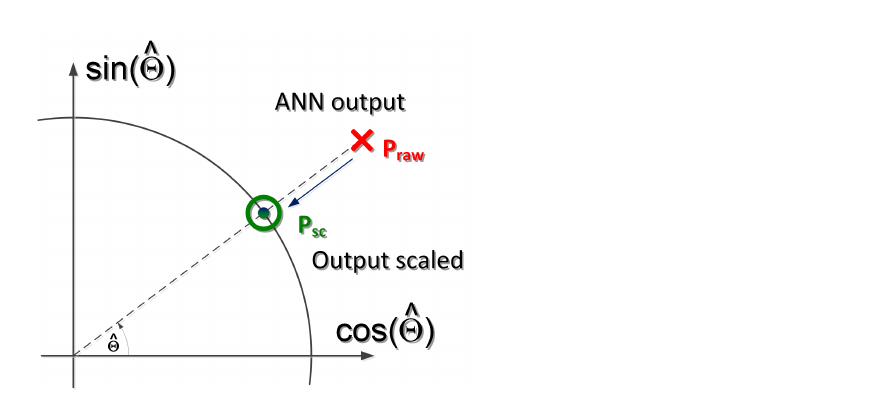
Figure 4. Visualization of the concept of scaling the data generated by